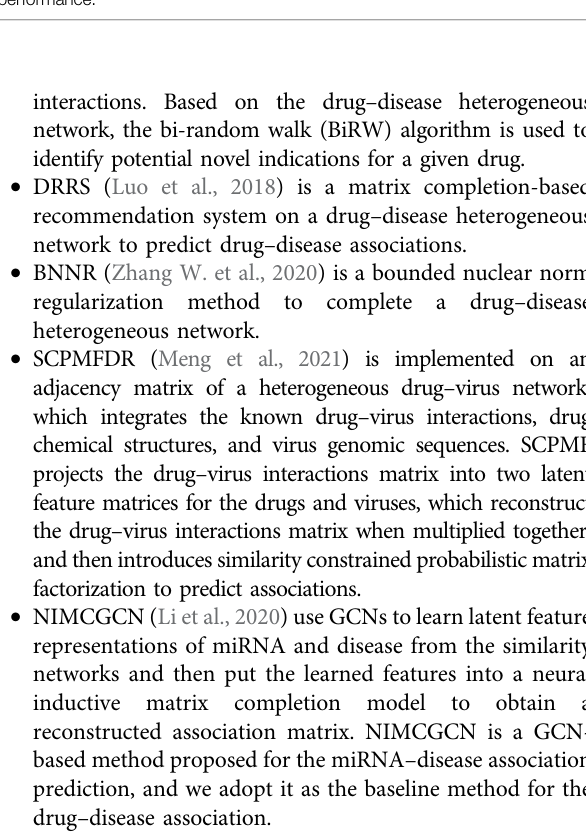
FIGURE 4 | Effect of the number n k of neighbor samples on performance.